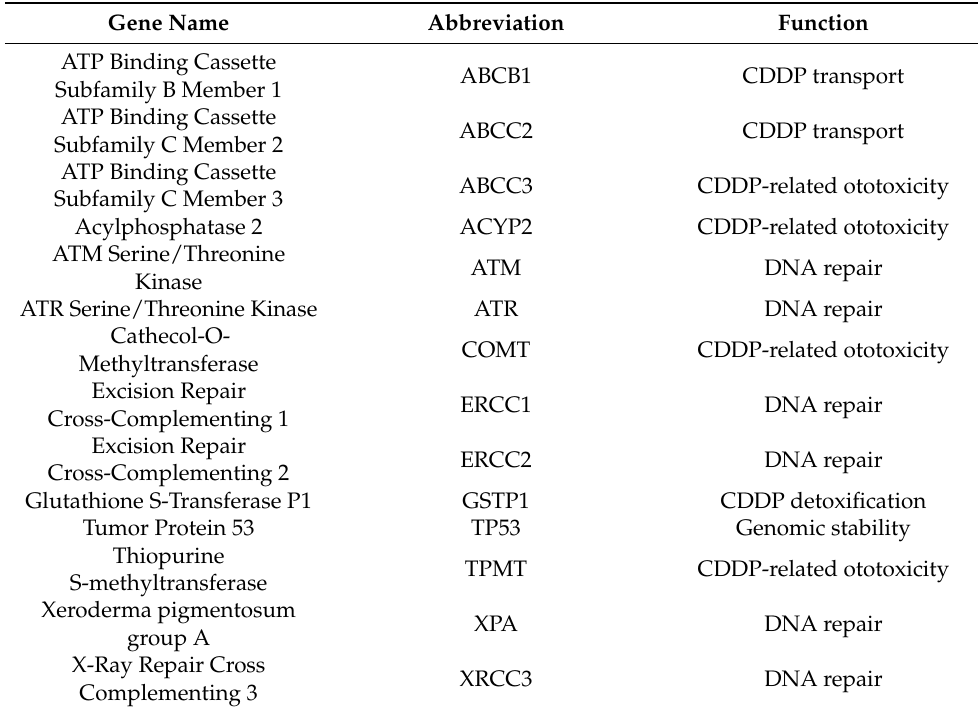
Table A1. List of genes and their main function selected for this study.